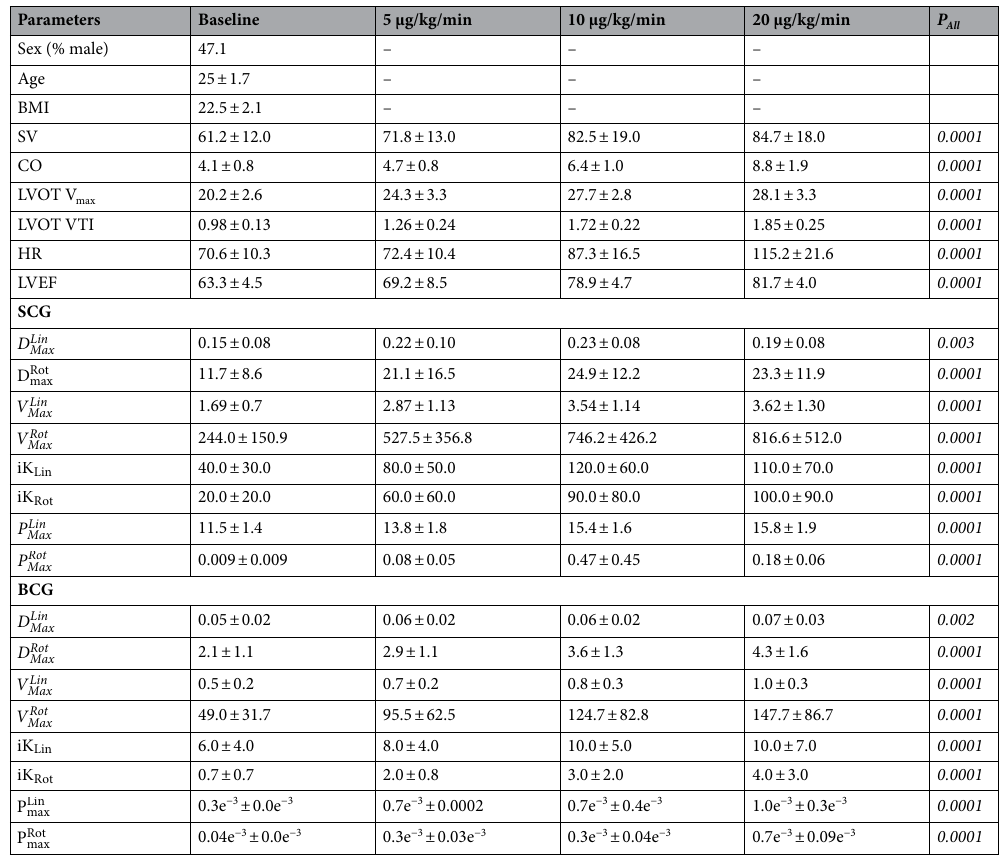
Table 1. Modifications of metrics of echocardiography and SCG/BCG according to the dose of dobutamine infusion. One-way parametric or non-parametric ANOVA was applied according to data distribution. For clarity purpose, continuous variables are all presented as mean ± SD. Statistical significance was set at 0.05 and emphasized in italics. BMI body mass index (kg/m 2 ), SV stroke volume (ml), CO cardiac output (l/min), LVOT V max left ventricle outflow tract maximal velocity (m/s), LVOT VTI left ventricle outflow tract integral Lin of velocity, HR heart rate (bmp); LVEF left ventricle ejection fraction (%); D max maximal displacement in the Rot V Lin linear dimension (mm/m 2 ), D max maximal Max maximal displacement in the rotational dimension (°/m 2 ), Rot iK Lin velocity in the linear dimension (mm/s/m 2 ), V max maximal velocity in the rotational dimension (°/s/m 2 ), integral of kinetic energy in the linear dimension (µJ s/m 2 ), iK Rot integral of kinetic energy in the rotational Lin P Rot dimension (µJ s/m 2 ), P Max maximal power in the linear dimension (J/s/m 2 ), Max maximal power in the rotational dimension (mJ/s/m 2